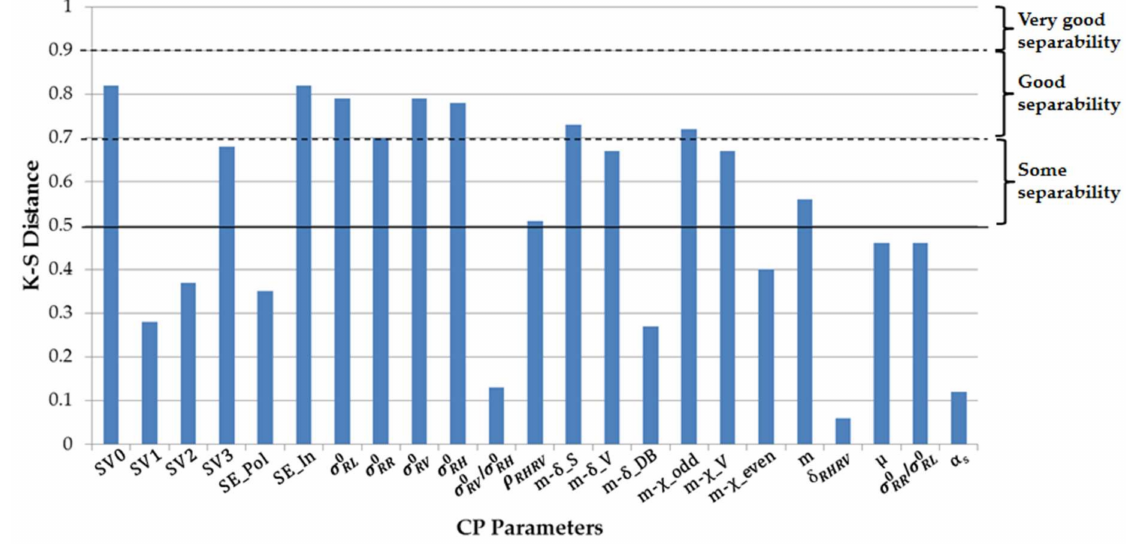
Figure 4. K-S distance between FYI and MYI in the assessed CP parameters for the RCM HR